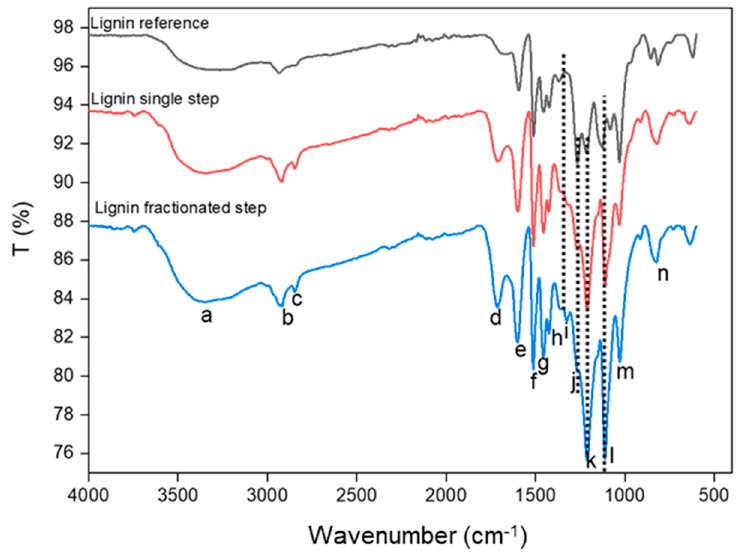
Figure 3. Functional group peaks of reference lignin, isolated lignin from single-step and fractionated-step by UATR-FTIR. Table 2. Interpretation bands of UATR-FTIR spectra.